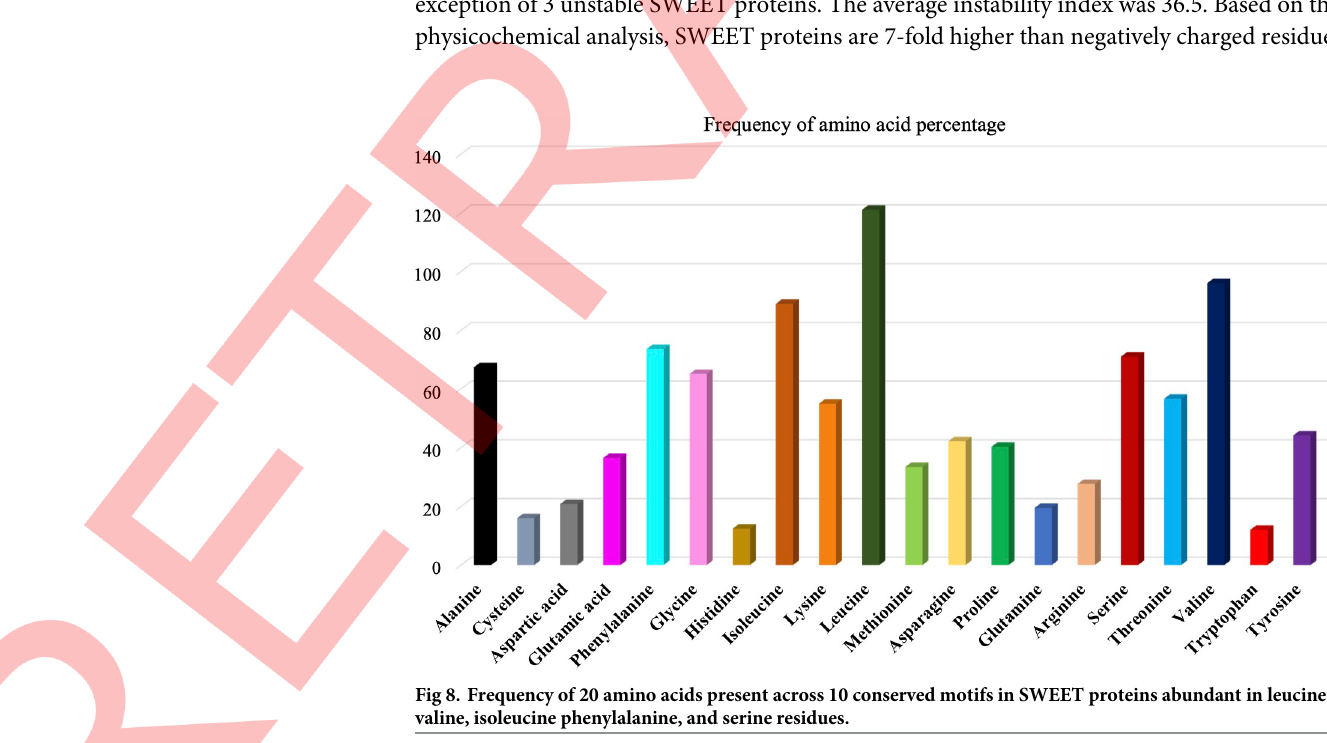
Fig 8. Frequency of 20 amino acids present across 10 conserved motifs in SWEET proteins abundant in leucine, valine, isoleucine phenylalanine, and serine residues.